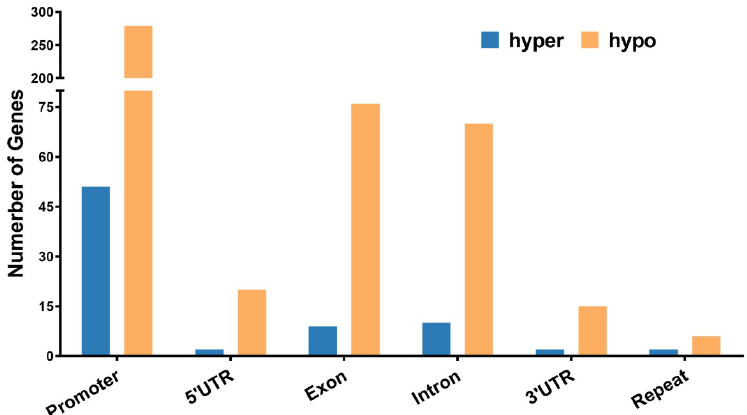
Figure 5. Number of hypomethylated and hypermethylated DMGs in gene functional regions. Hypo: hypomethylated; hyper: hypermethylated.